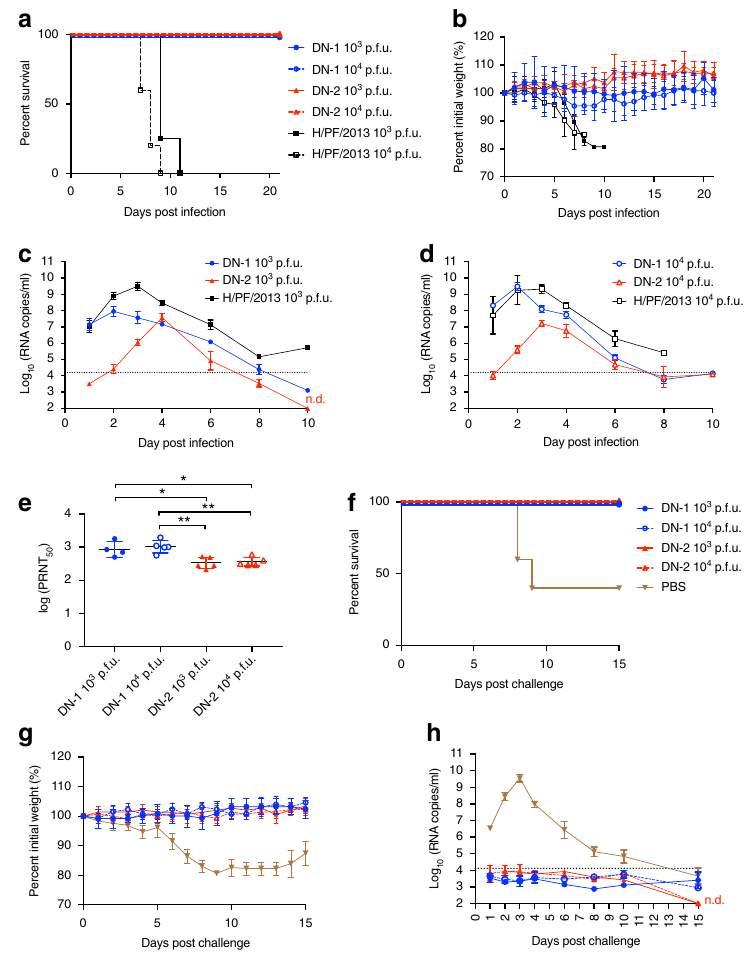
Fig. 7 DN-2 displays attenuated replication in A129 mouse model and elicits protective responses against lethal wild-type ZIKV challenge. Male A129 mice were inoculated i.p. with 10 3 or 10 4 p.f.u. of DN-1, DN-2, or H/PF/2013 ( n = 5 per group except n = 4 for mice that received 10 3 p.f.u. of DN-1 and H/PF/ 2013) and monitored for a survival, b weight changes and viremia levels after infection with c 10 3 and d 10 4 p.f.u. of each virus. e Immune sera from surviving mice obtained at 21 days post inoculation to determine neutralizing antibody titers using PRNT and the log 50% neutralizing titers [log(PRNT 50 )] are as shown. These mice, together with a group of mice that received PBS at day 0 ( n = 5), were challenged with 10 4 p.f.u. of H/PF/2013 i.p. at 21 days post inoculation. f Survival, g weight changes, and h viremia levels were tracked for 15 days or until euthanasia for control mice with >20% weight loss. Error bars represent s.d. * p < 0.05, ** p < 0.01 in unpaired t test. Dotted lines on viral quanti fi cation graphs represent limit of detection. n.s. not signi fi cant,